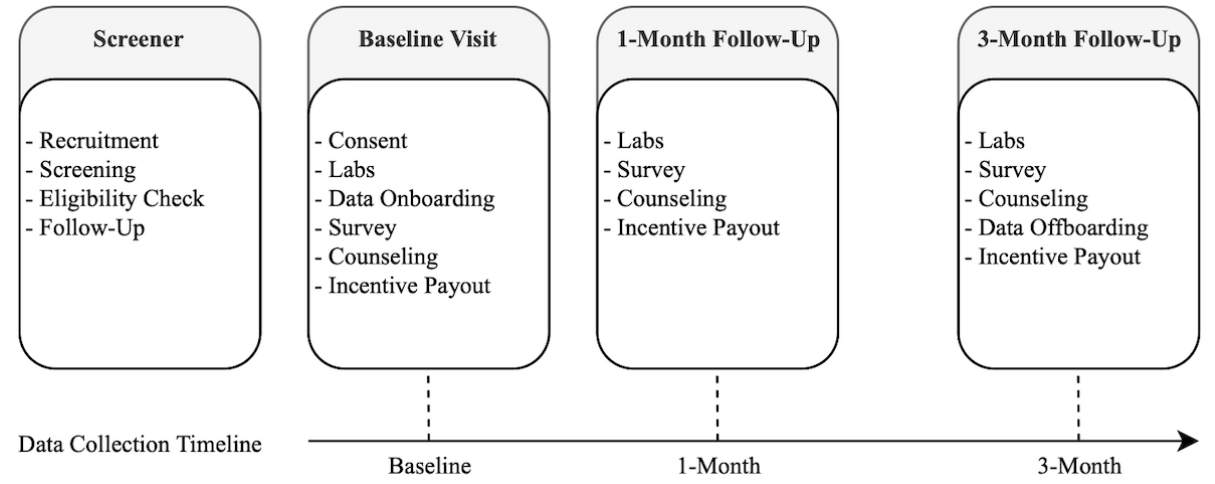
(Figure 1). In the screener, flyers, online advertisements, and referrals were used to recruit potential participants. Further Figure 1. Different phases of the study protocol and data